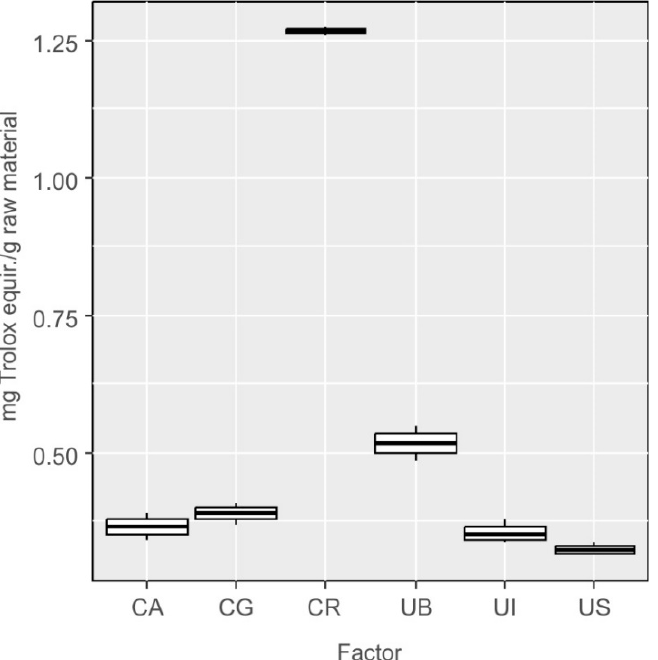
Figure 6. Results of determination of the content of compounds with antioxidant activity in extracts from Cladophora and Ulva species using the ABTS method, converted into milligram equivalents of trolox per gram of raw material.